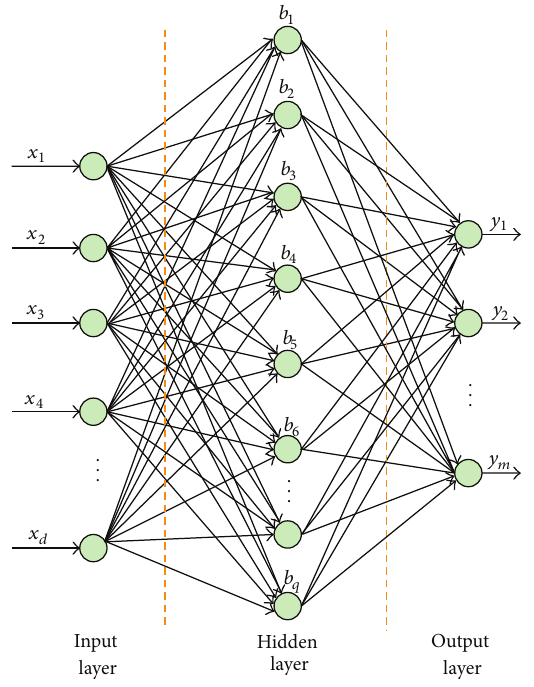
Figure 1: Architecture of the RBF neural